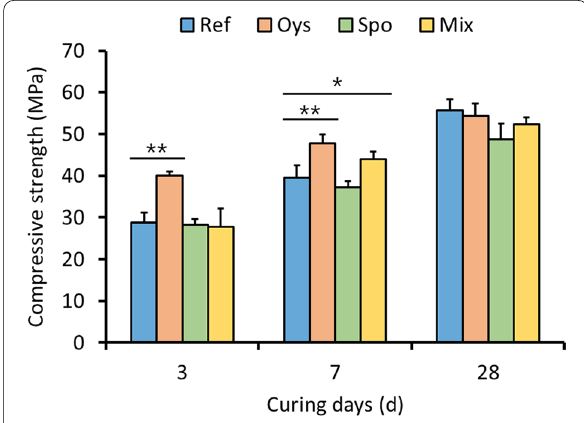
Fig. 5 Compressive strength development of four types of mortar specimens per curing period. *p < 0.01; **p <